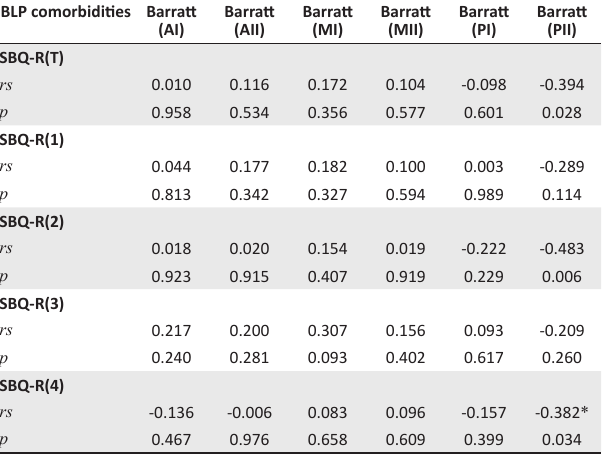
TABLE 3: Spearman correlation between Suicide Behavior Questionnaire-Revised and Barratt’s Impulsiveness Scale-11 in borderline personality disorder with axis I